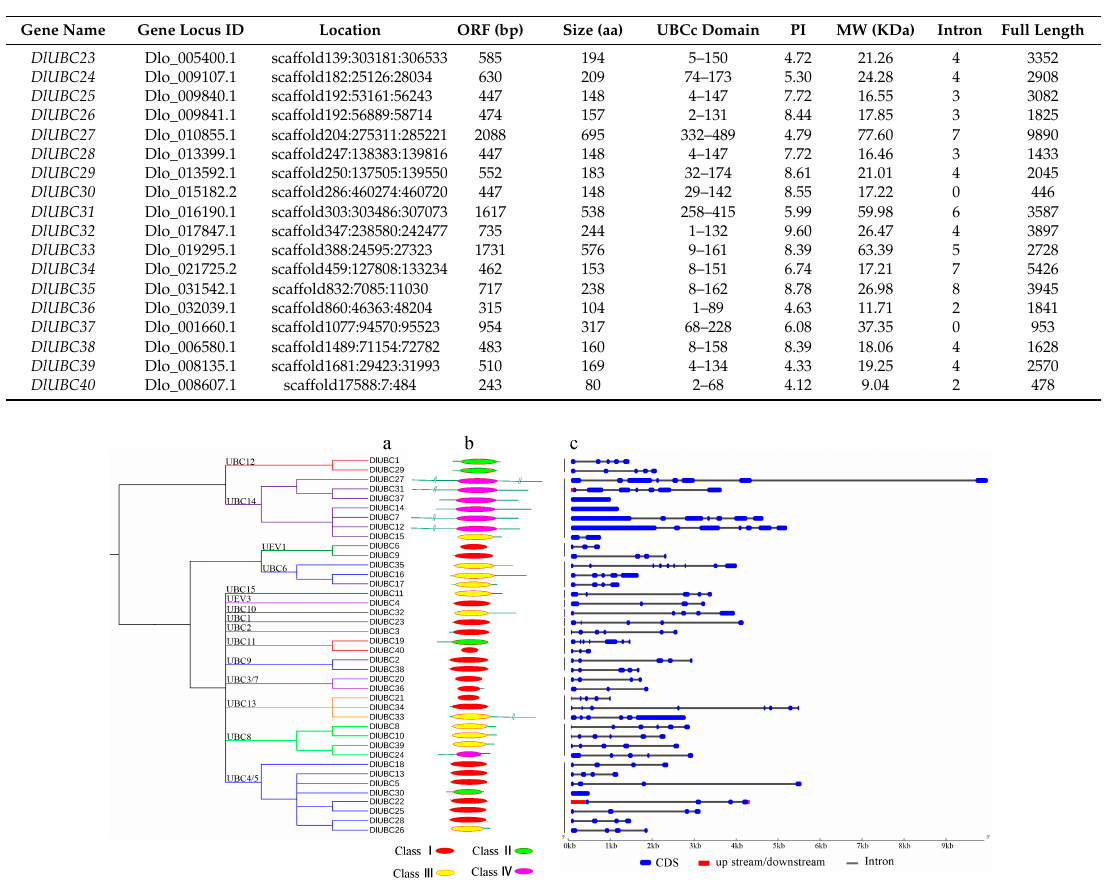
Figure 1. Phylogenetic relationships, architecture of conserved protein motifs and gene structure in DlUBC genes from longan. ( a ) The neighbor-joining (NJ) tree on the left includes 40 DlUBC proteins from longan; ( b ) The architecture of conserved protein motifs of DlUBC proteins with the name of each corresponding protein is shown on the left. The position of the UBC domain is indicated in the panel. The different colors indicate the four E2 subtypes of the UBC domains; ( c ) Exon/intron structures of UBC genes from longan. Untranslated 5 ′ and 3 ′ regions, exon(s), and intron(s) are represented by red, blue boxes, and gray lines, respectively. The scale bar represents 1000 bp.